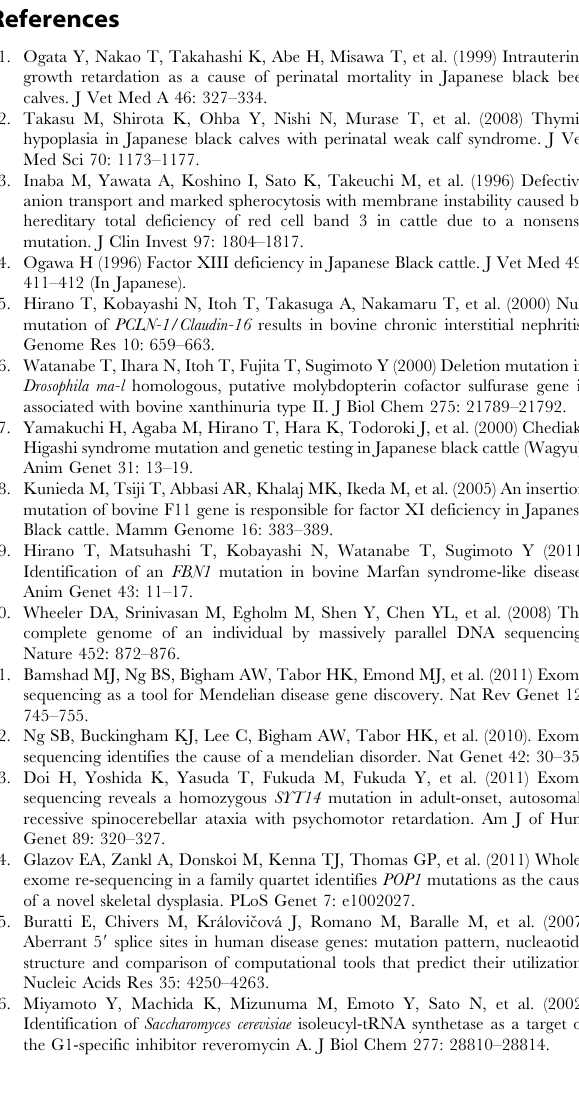
Table S1 Primers used to sequence all exons of the bovine IARS . Table S2 Primers used to prepare the wild-type and mutant IARS